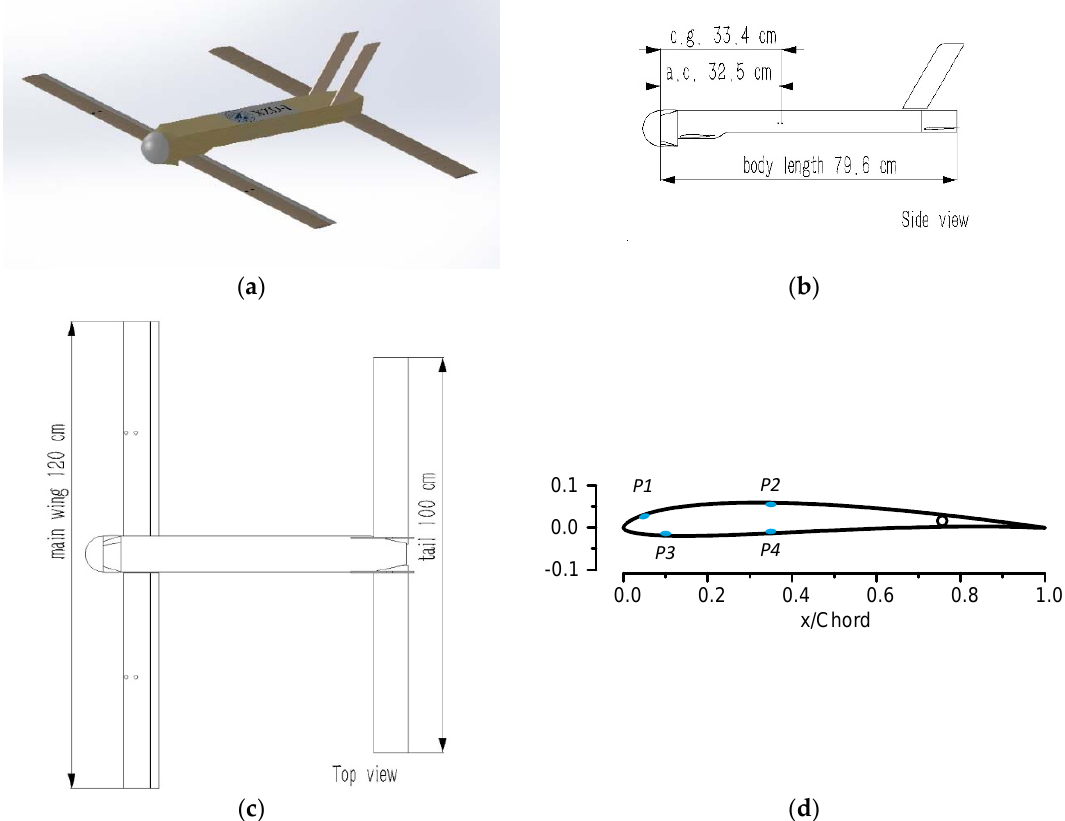
Figure 1. Small unmanned aerial vehicle (SUAV) model and pressure sensor configuration: ( a ) the XZD-I SUAV; ( b ) positions of the center of gravity (c.g.) and aerodynamic center (a.c.); ( c ) top view of the SUAV; ( d ) site of the sensors in the airfoil section.